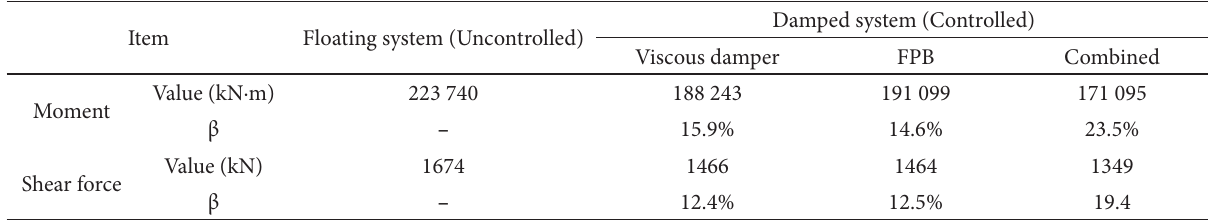
Table 4. The maximum moment and shear force at the bottom of the tower